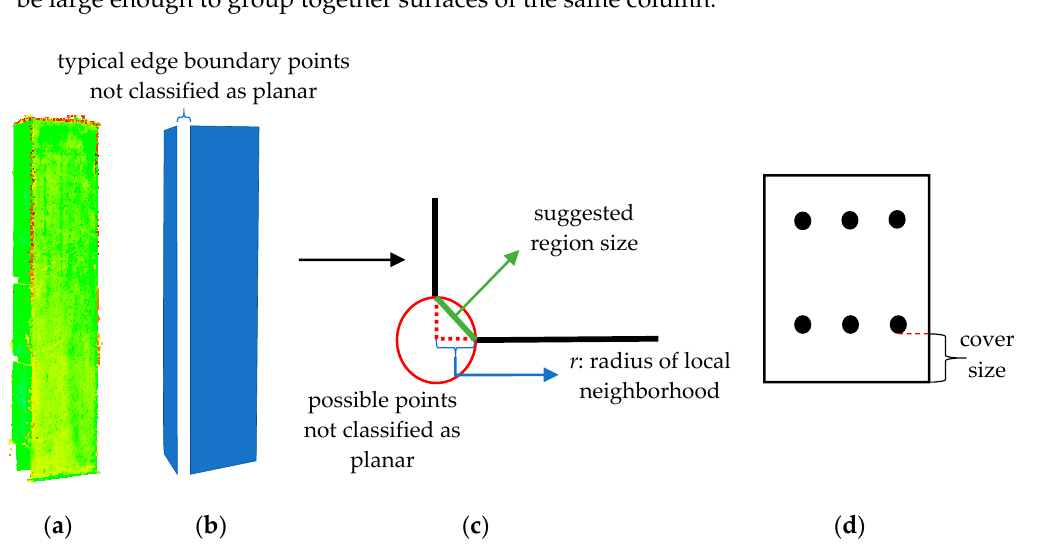
Figure 3. ( a ) Typical point cloud of a rectangular column; ( b ) schematic planar classification of the column surfaces using classical PCA; ( c ) the top view of the potential points identified as planar using classical PCA; ( d ) cross-sectional view of a reinforced concrete column and rebar cover.